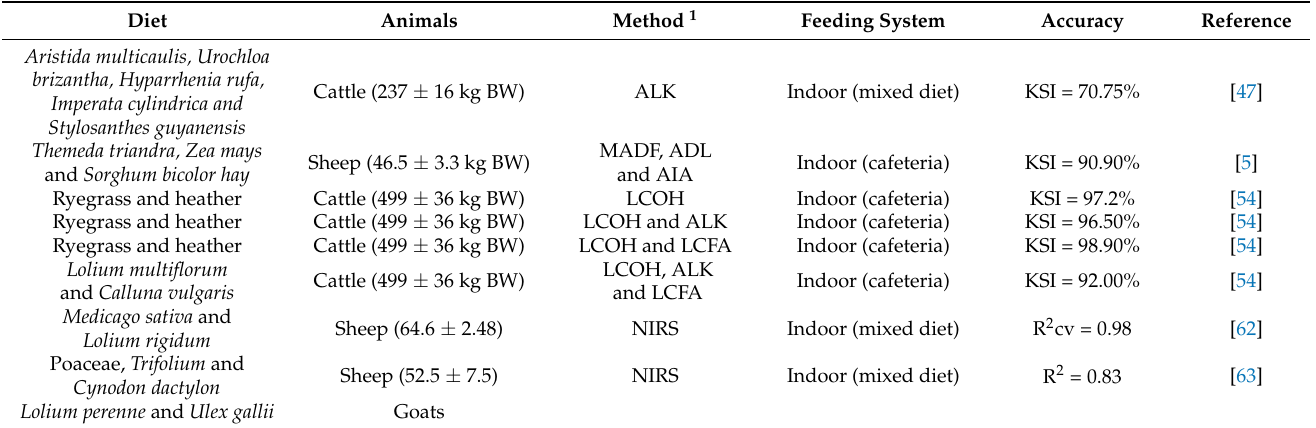
Table 2. Comparison of the accuracy of techniques used to determine diet selection in